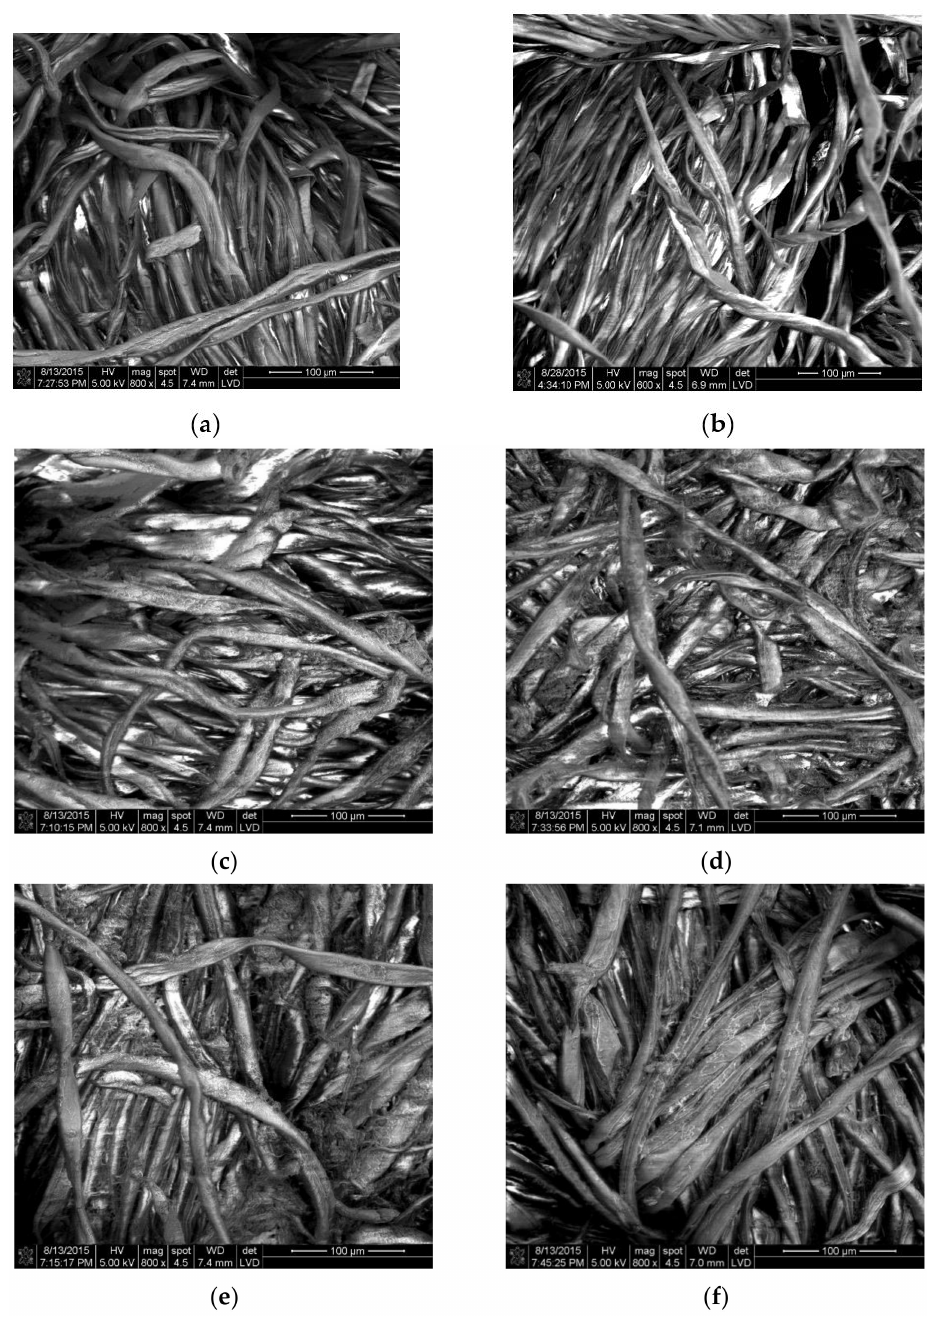
Figure 4. SEM images of ( a ) cotton textile, ( b ) pretreated textile with H 2 O 2 , ( c ) composite 1, ( d ) com- posite 2, ( e ) composite 3, and ( f ) composite